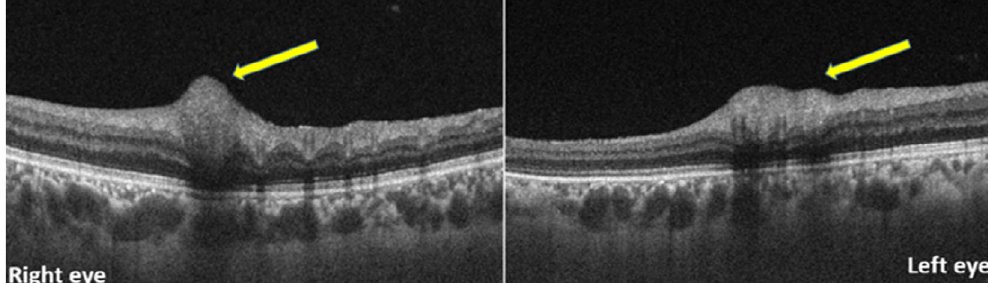
Figure 3. Optical coherence tomography passing through cotton wool spots revealed focal hyperreflectivity in the inner/middle retinal layers (yellow arrows).